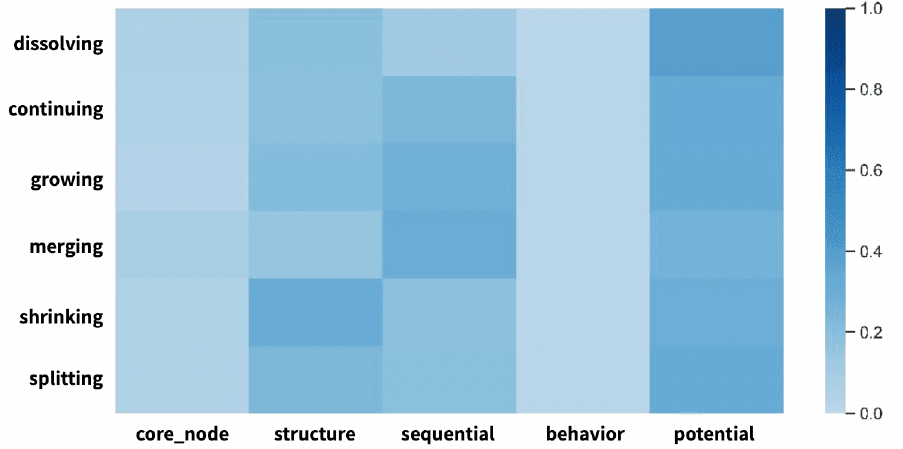
Figure 7. Distribution of importance of various features in the Bitcon data